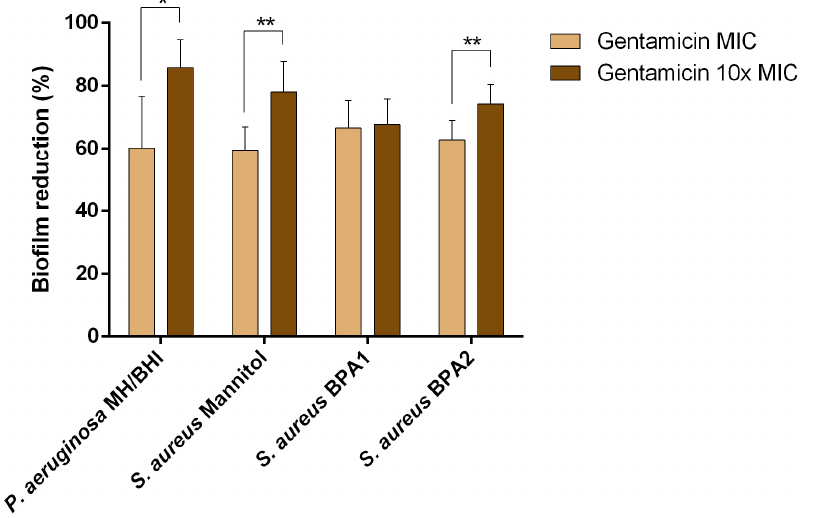
Figure 2. Percentage of biofilm reduction of S. aureus and P. aeruginosa isolates exposed to the MIC and 10 × MIC of gentamicin for 24 h. The mean ± standard deviation of three independent experiments is illustrated. ** p ≤ 0.01; * p < 0.05. Table 3. Classification of treatment efficacy in biofilm removal according to Lemos et al.